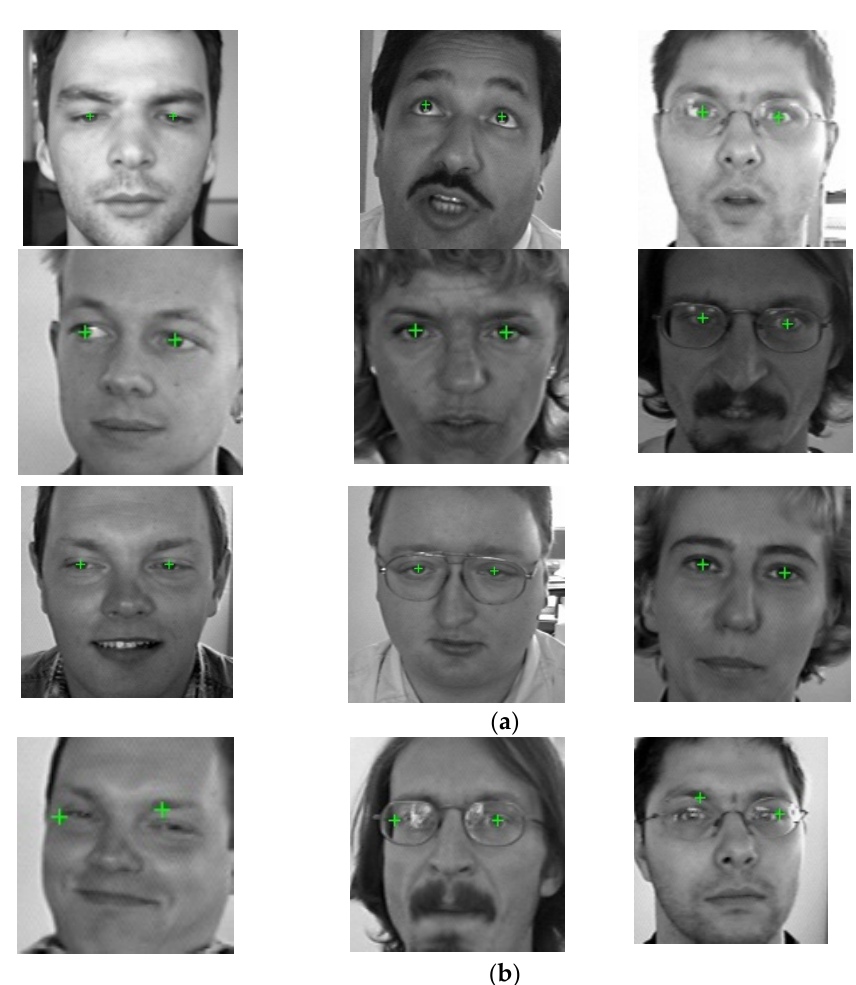
Figure 13. Iris center localization results on the BIO-ID face database. ( a ) Iris center localization results; and ( b ) iris center localization results—failure cases.